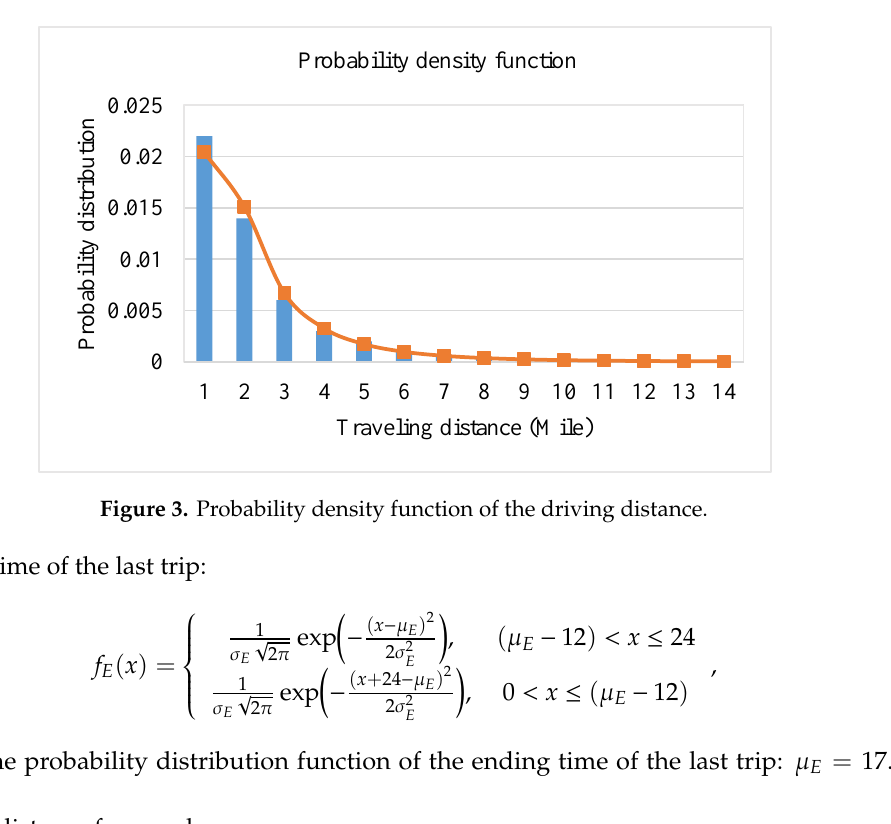
Figure 2. Probability density function of the ending time of the last trip.